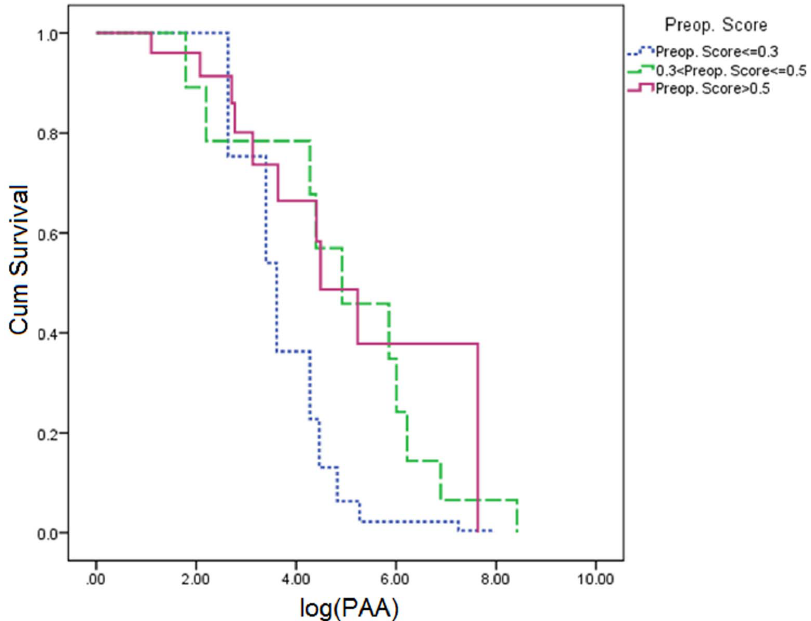
Figure 4. Survival curves as a function of the logarithm of the total number of PAA experienced before AF onset in 3 groups defined by their preoperative score ƒ 0.3, [0.3–0.5], and 0.5.